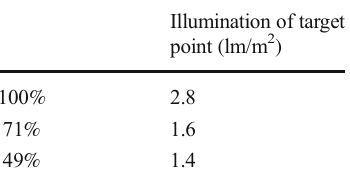
Illumination of target point (lm/m 2